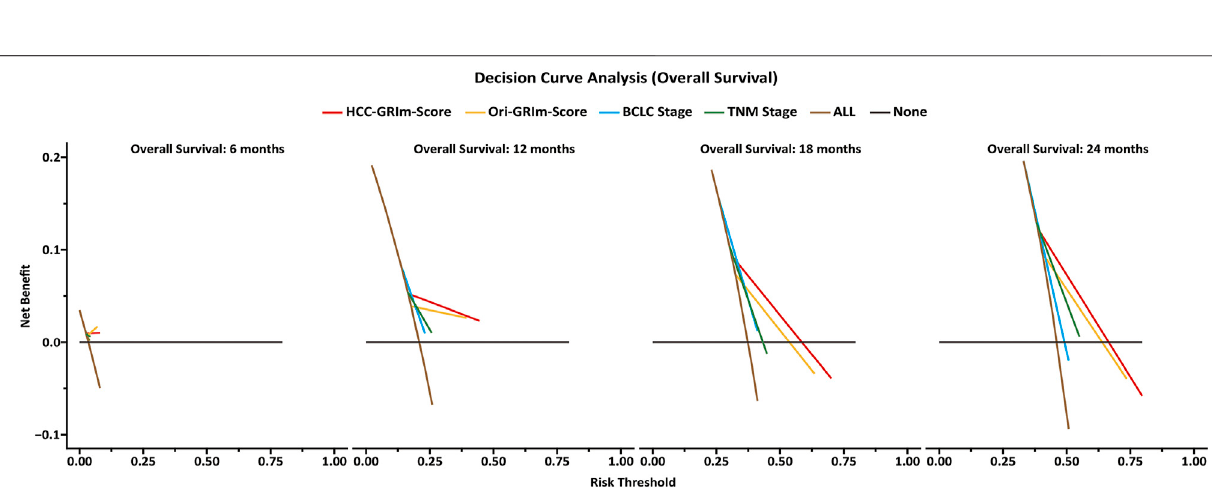
Frontiers in Pharmacology |